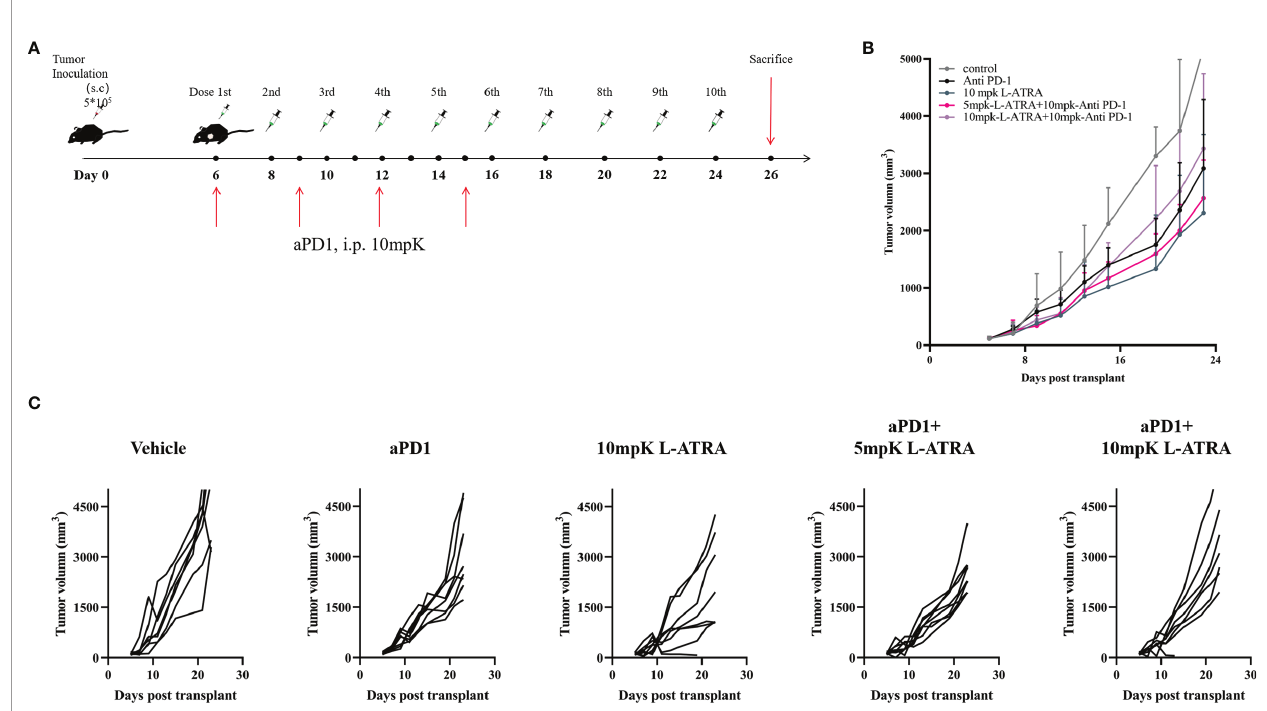
FIGURE 7 | The tumor growth inhibition effects of L-ATRA combined with anti-PD-1 treatment. (A) Outline of the dose schedule; (B) Analysis of Tumor growth in different treatment groups; (C) . Individual tumor growth curves in different treatment